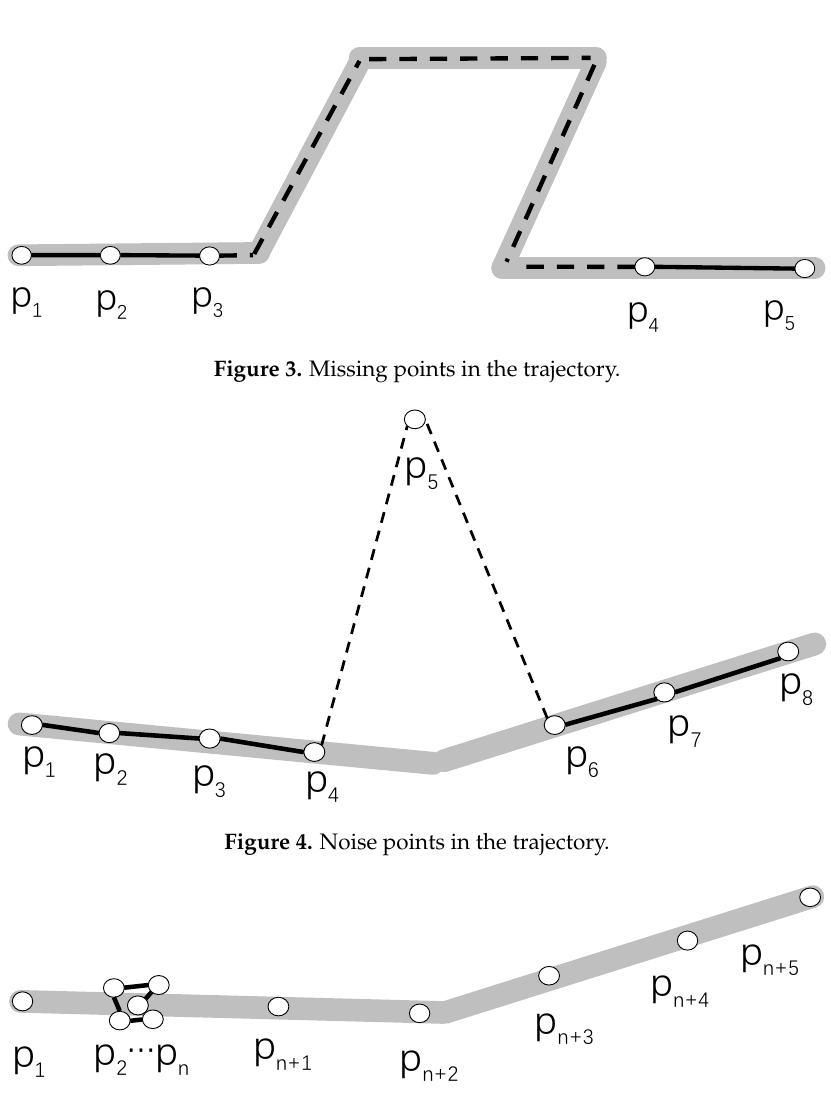
Figure 5. Stationary points in the trajectory.